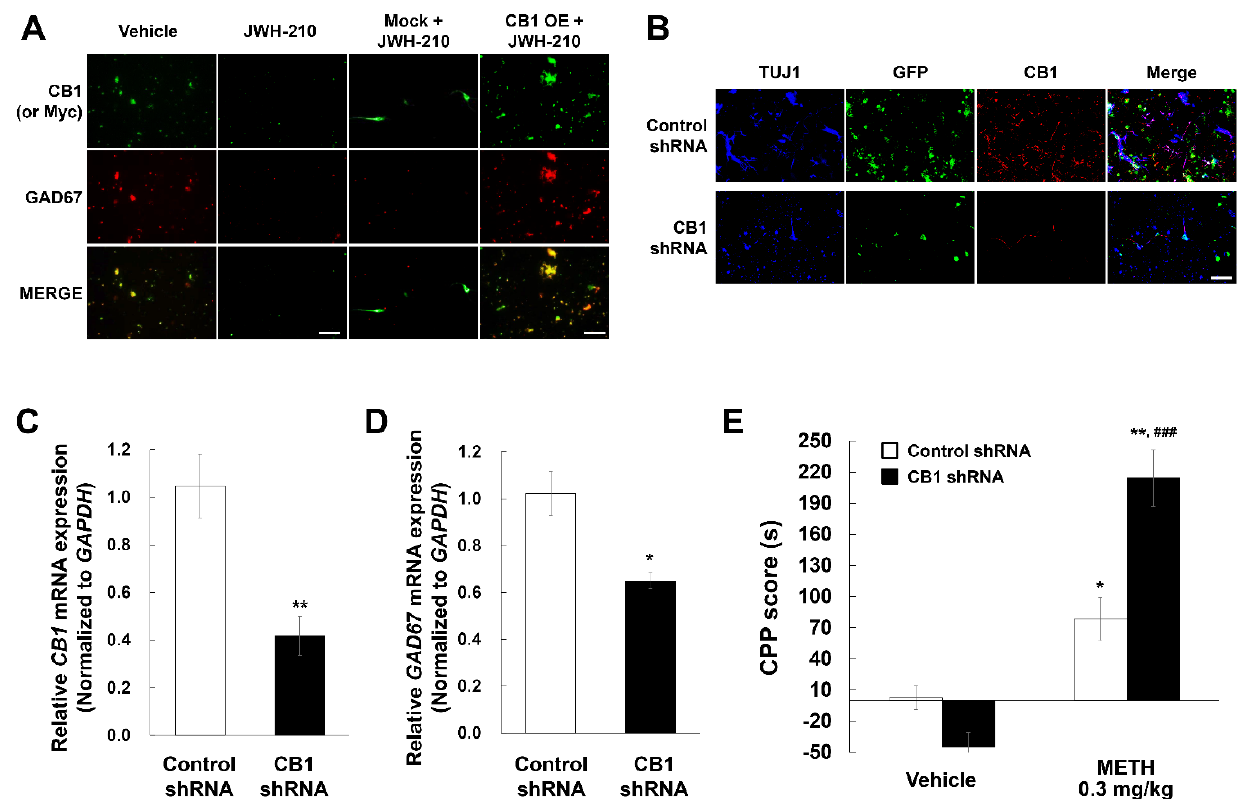
Figure 4. Effects of CB1 knockdown on GAD67 expression in primary cultured neurons and METH-induced CPP. ( A ) Vehicle group was treated with vehicle (5% DMSO, 5% tween-20, 90% PBS) as the same amount of JWH-210 for 24 h. JWH-210 group was treated with 0.1 µ M JWH-210 for 24 h. Mock + JWH-210 and CB1 overexpression (OE) + JWH-210 groups were treated with mock or CB1 ORF lentiviral particles (5 MOI) for 24 h before treatment with vehicle or 0.1 µ M JWH-210 for 24 h. Immunostaining of CB1, Myc, and GAD67 was performed with specific antibodies (Scale bar: 200 µ m). ( B ) Cultured neurons were treated with control or CB1 shRNA lentiviral particles. mRNA levels of ( C ) CB1 and ( D ) GAD67 were confirmed by using qPCR with each specific primer and normalized to the relative amplification of GAPDH. Data are expressed as the mean ± S.E. ( n = 6; Student’s t -test; * p < 0.05 and ** p < 0.01 vs. vehicle group). ( E ) After CB1 knockdown, 0.3 mg/kg METH-induced CPP scores (s) was measured by CPP test. Data are expressed as the mean ± S.E. ( n = 8) and were analyzed using two-way ANOVA followed by Bonferroni post-hoc t -test (* p < 0.05 and ** p < 0.01 vs. each saline group; ### p < 0.001 vs. Control shRNA/METH group). OE: overexpression. TUJ1: beta-tubulin III. METH: methamphetamine.